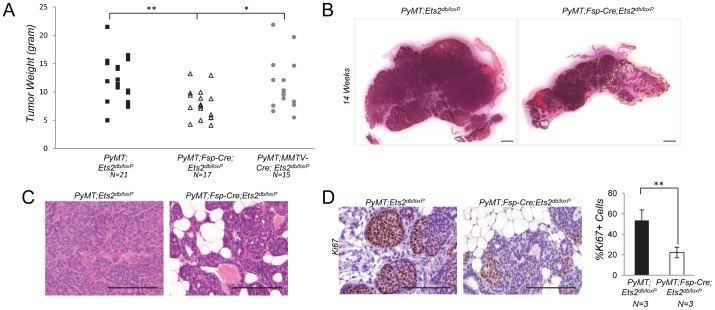

Ets2 ablation in stromal fibroblasts restricts PyMT driven mammary tumorigenesis.
A. Dissected tumor weight in grams isolated from 14 week old PyMT;Ets2db/loxP (n = 21, 12.36±3.8), PyMT;Fsp-Cre;Ets2db/loxP (n = 17, 7.83±2.7), and PyMT;MMTV-Cre;Ets2db/loxP (n = 15, 11.3±4.7) mice (**P<0.01, *P<0.05, adjusted P-values were obtained from an ANOVA model assuming unequal variance with Holm’s methods). B. Representative H&E stained mammary glands from 14 week old PyMT;Ets2db/loxP and PyMT;Fsp-Cre;Ets2db/loxP mice. Area outlined in yellow represents less advanced tumor progression. Scale bar, 2mm. C. Representative histological sections from mammary glands of 10 week old PyMT;Ets2db/loxP and PyMT;Fsp-Cre;Ets2db/loxP mice. Scale bar, 50 µm. D. Left: representative IHC staining for Ki67 in mammary glands of 10 week old PyMT;Ets2db/loxP and PyMT;Fsp-Cre;Ets2db/loxP mice. Scale bar, 50 µm. Right: graph represents percentage of Ki67 positive epithelial cells (n = 3, bars represent means ± SD, **P<0.01, unpaired Welch’s t-test assuming unequal variance).